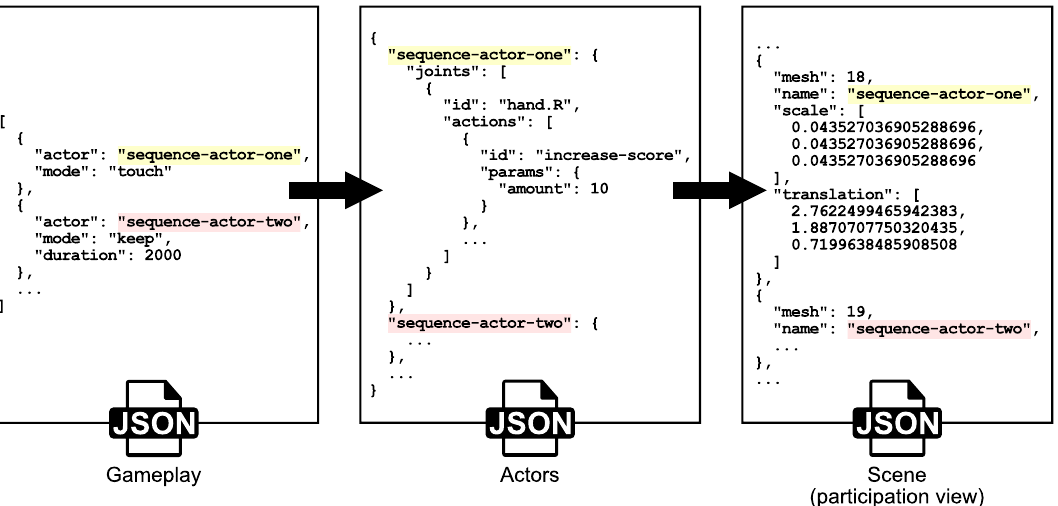
Figure 5. Pieces of data models that make an exergame. References to actors between three files of the game mechanics highlighted in